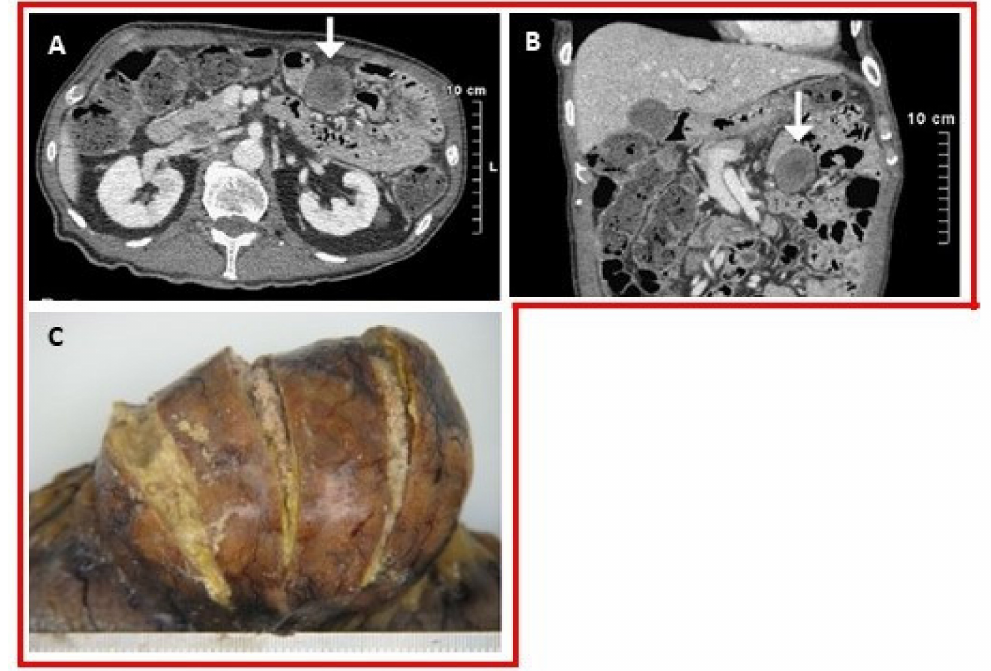
Figure 5. ( A ) Axial and ( B ) coronal images of a contrast-enhanced abdominal CT reveals a mass arising from the small bowel (white arrow) [76]. ( C ) Photograph of the resected specimen demonstrates a subserosal mass arising from the small bowel with yellowish material emanating from the